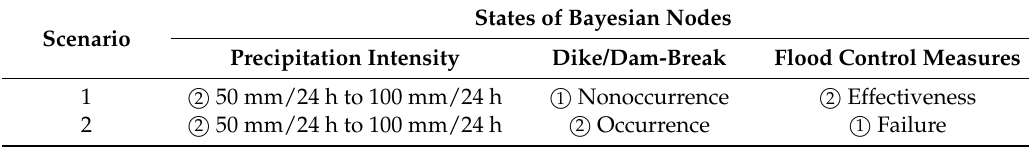
Table 7. Given state evidences of some BN